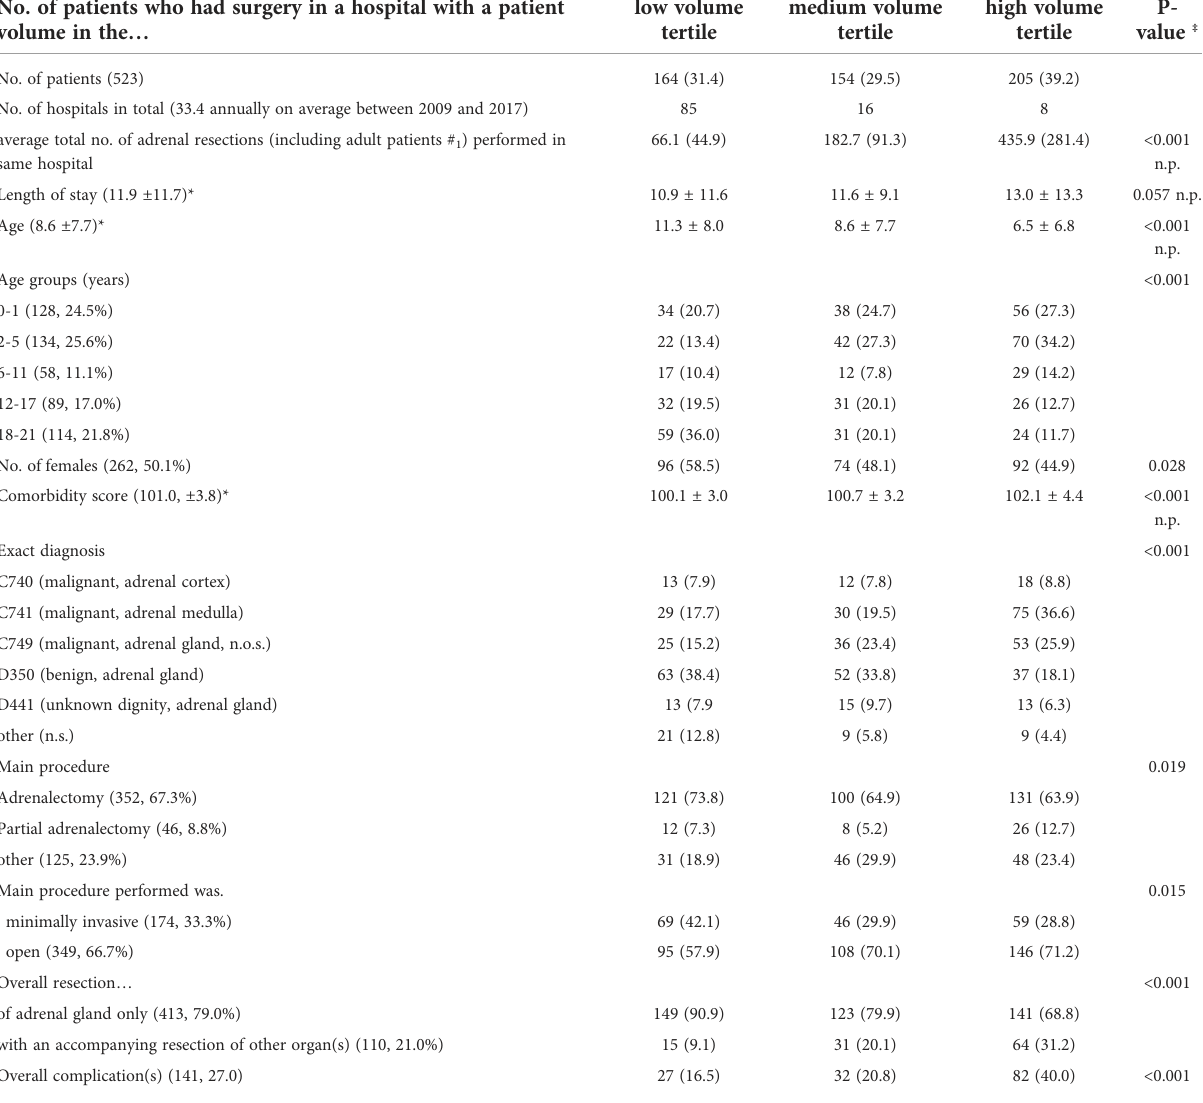
TABLE 3 Patients ≤ 21 years of age: patient characteristics by hospital